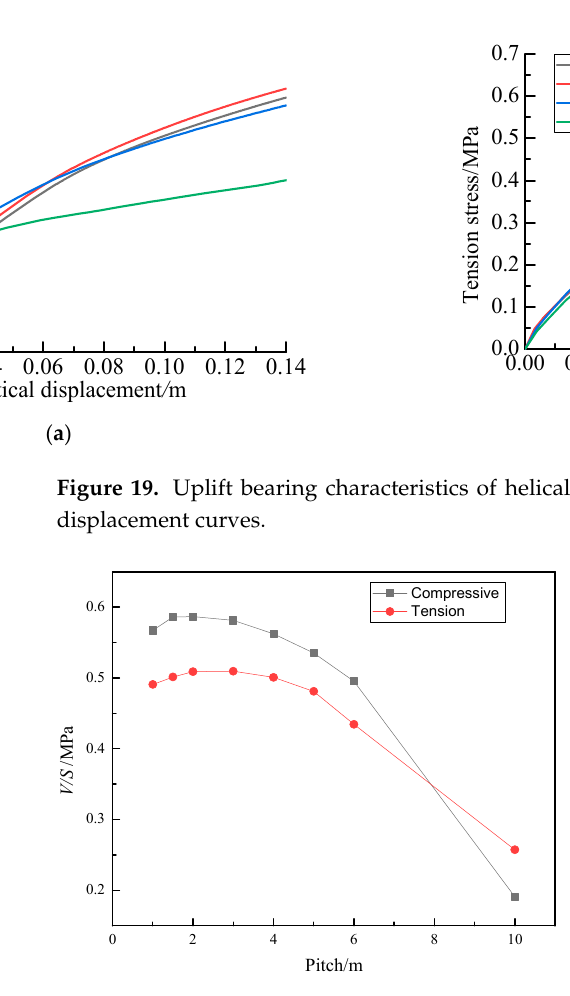
Figure 20. V/S ratio of helical pile with different pitches at displacement of 0.1 m. Figure 20. V / S ratio of helical pile with different pitches at displacement of 0.1 m.